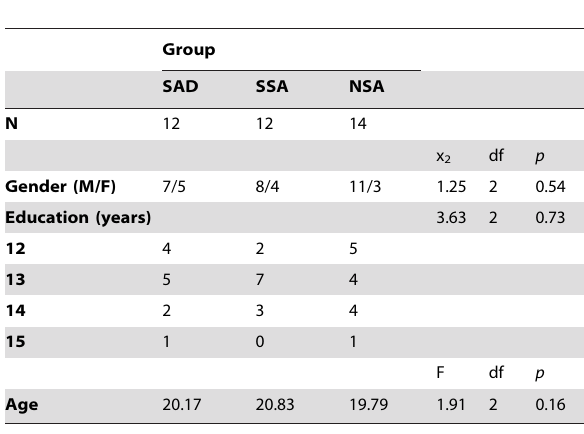
Table 1. Demographic characteristics of groups SAD, SSA, and